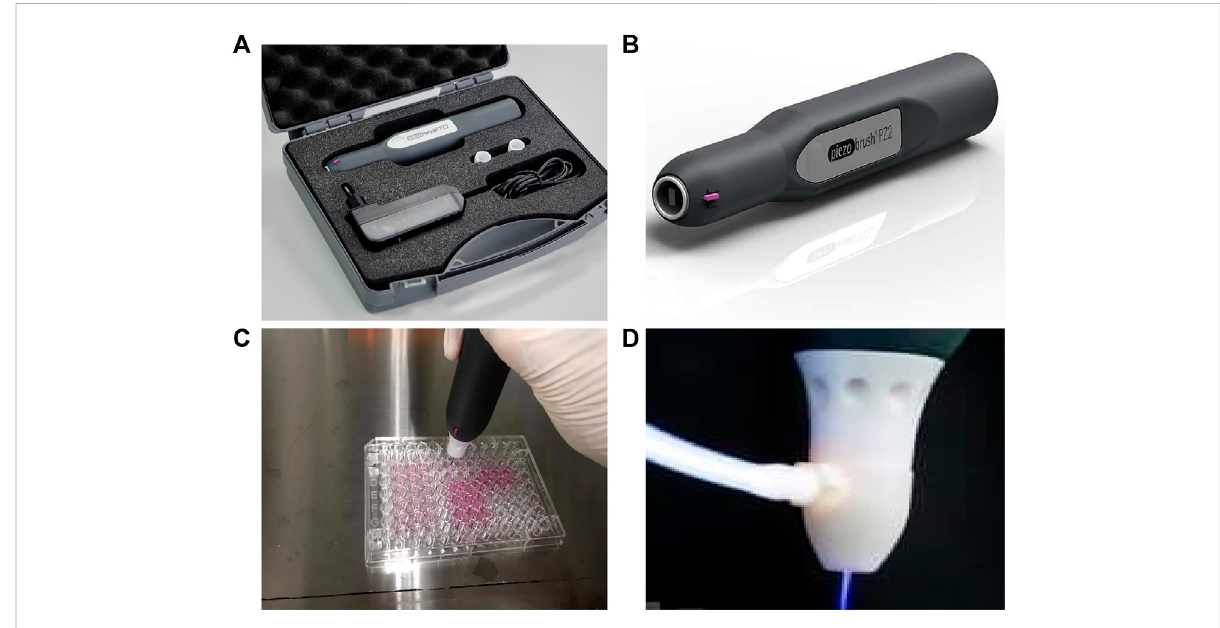
FIGURE 1 IllustrationoftheCAPdevice,Piezobrush ® PZ2,usedinthisstudy. (A,B) ContentandportabilityoftheCAP PZ2 kit. (C) Cellulartreatmentusingthe handheld plasma device. (D) Close-up of the plasma nozzle in the operating